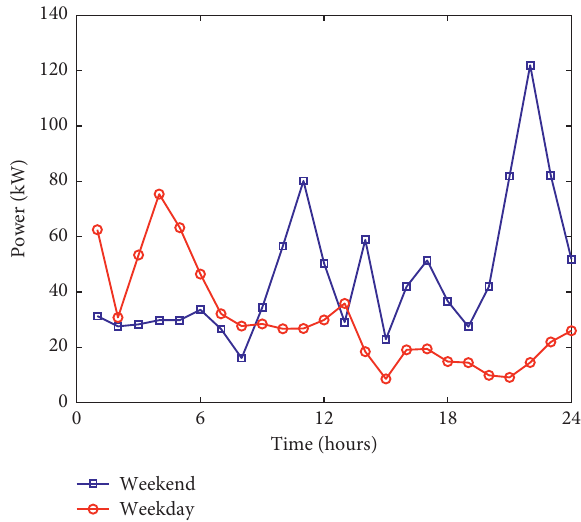
Figure 4: Weekend and weekday